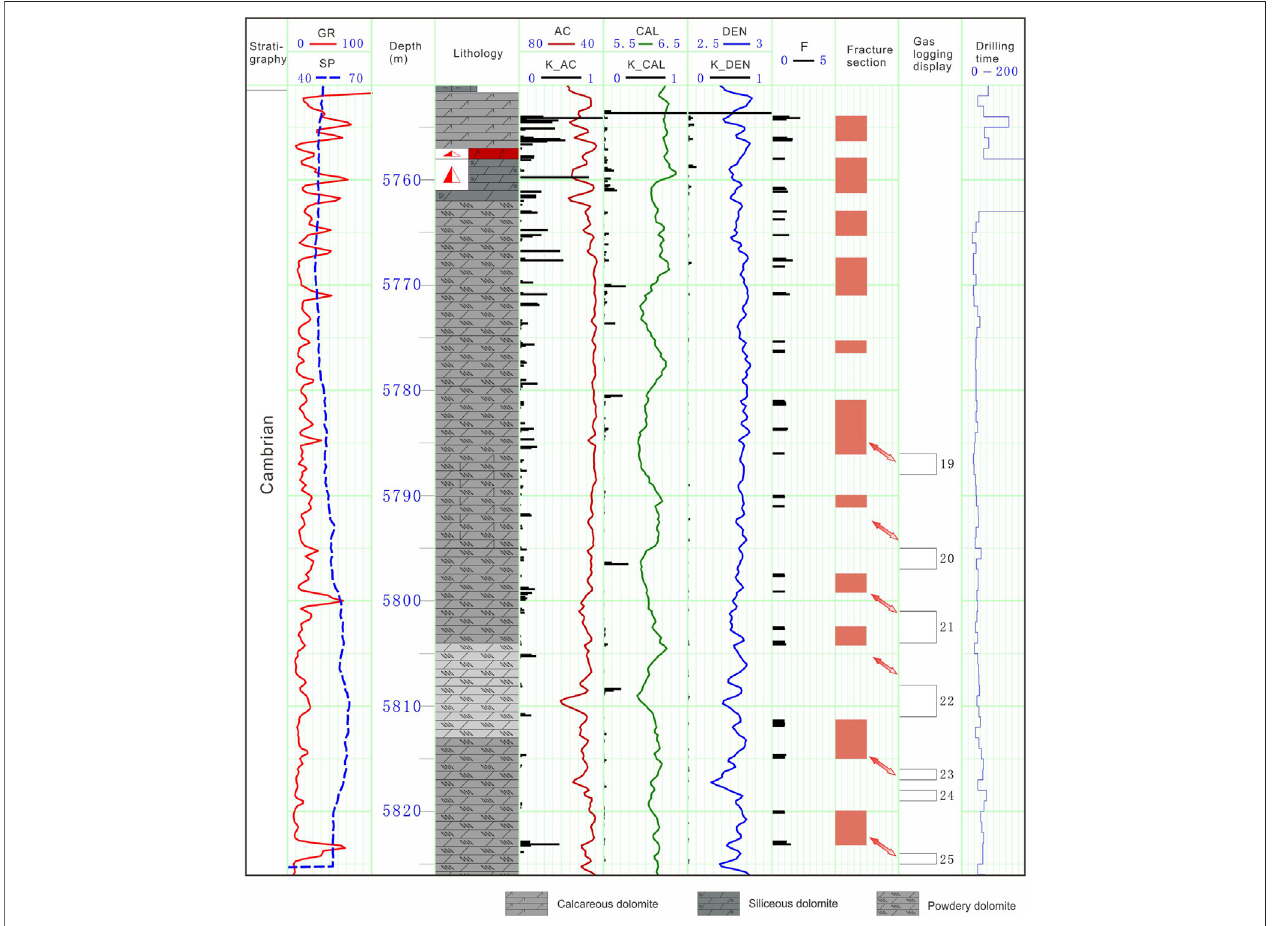
FIGURE 8 | Fracture development results identi fi ed with the R/S-FD method in well Q101. The red and white double arrows show the corresponding relationship between the fracture development section and the gas logging display section.